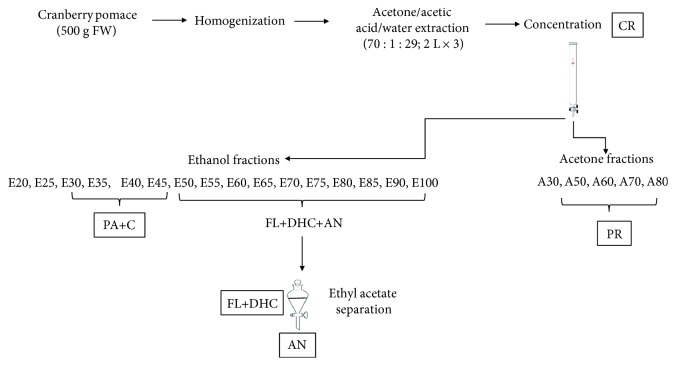
Process flow chart for extraction and fractionation of cranberry pomace (CP). PA: phenolic acids; DHC: hihydrochalcones; AN: anthocyanins; PR: proanthocyanidins; FL: flavonols.